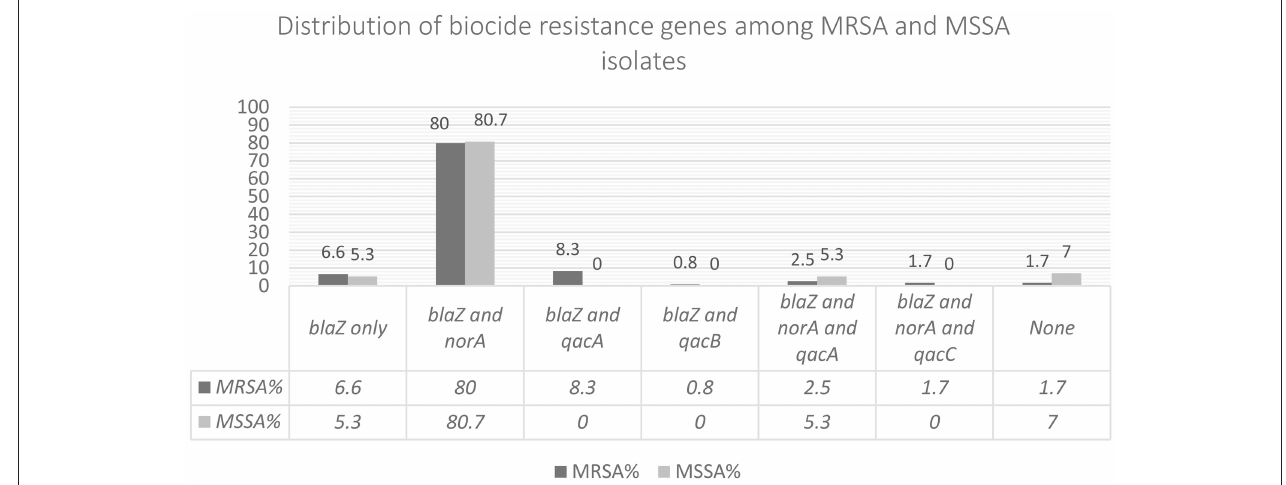
FIGURE 3 | In this figure the combination of biocide resistance genes observed among the isolates has been shown.